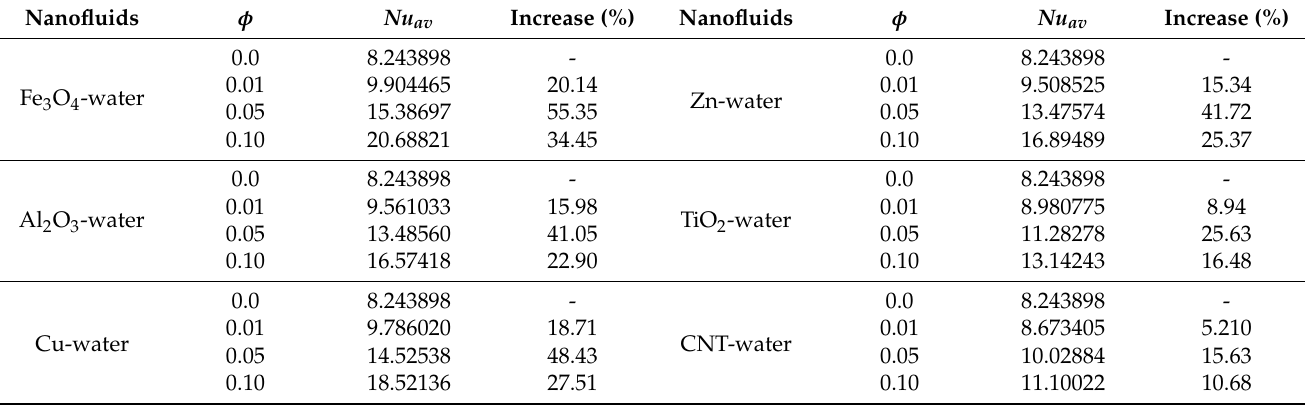
Table 3. Variation of mean Nusselt number ( Nu av ) for various nanoparticles volume ( φ ), and